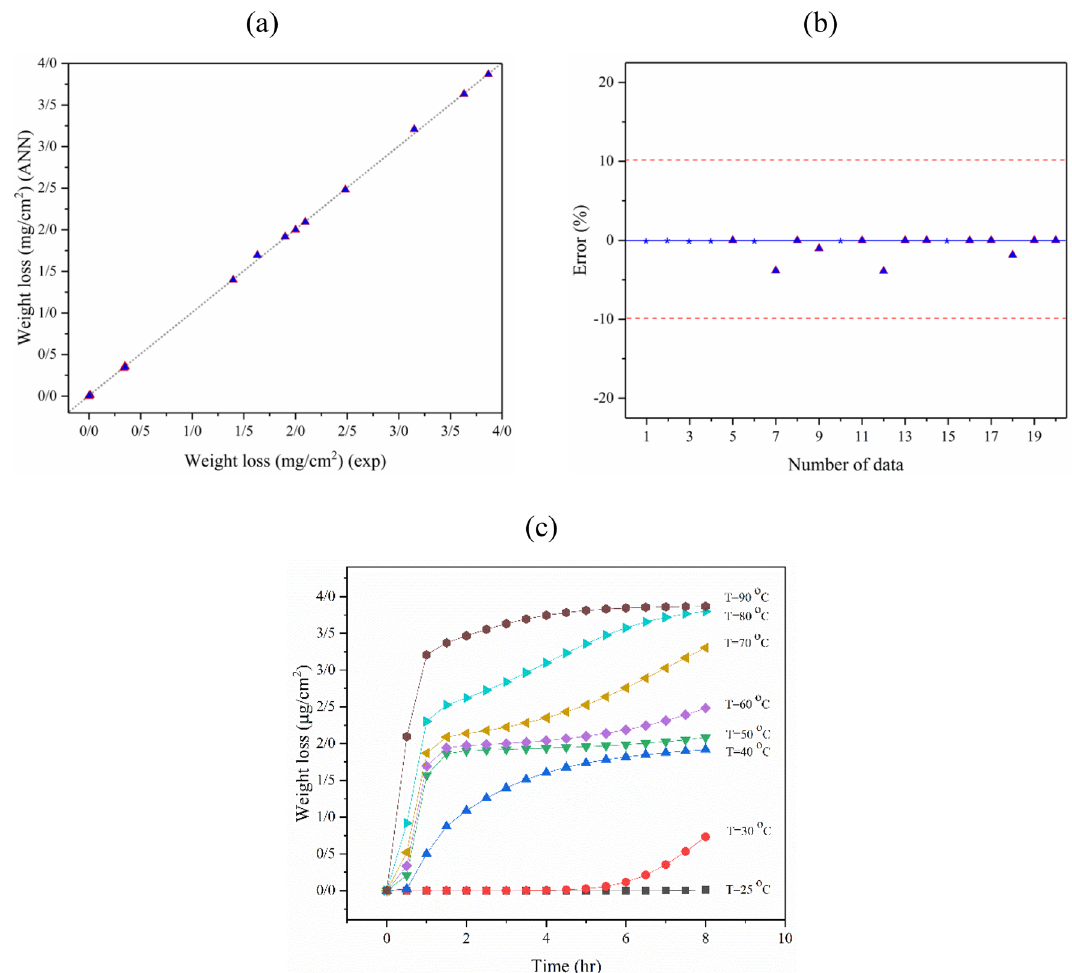
Figure 10. ( a ) Quality line, ( b ) the error values for experimental data and ANN model (R = 0.9991) outputs of WL (error for some points was unaccountable because of zero experimental values), and ( c ) the effect of time and temperature on the WL of the titanium surface after etching with an H 2 SO 4 etchant tion of transfer functions for the first and second hidden layers. A schematic of the optimized ANN topology is illustrated in Fig. 9. Comparison of experimental data with ANN-based WL predictions showed good accuracy with a correlation coefficient of 0.9991. The quality line and prediction error are presented in Fig. 10a,b. Finally, the variation of titanium WL in the H 2 SO 4 -based etching process under different etching times and solution temperatures is shown in Fig. 10c.